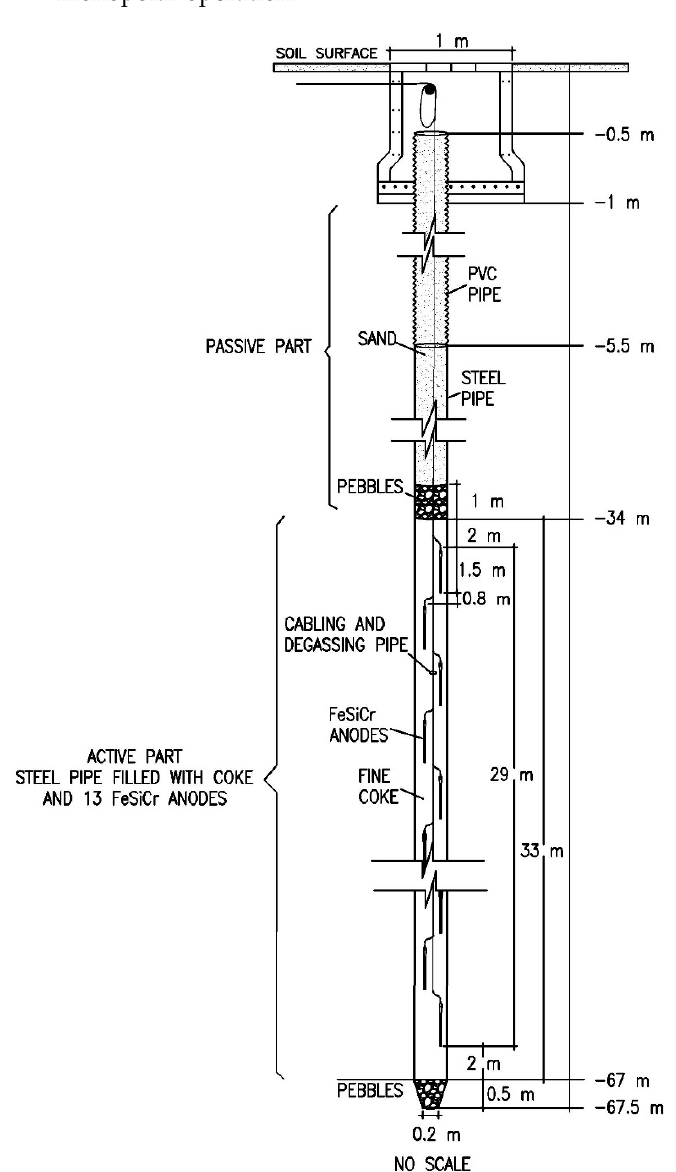
Figure 2. Well construction, 67 m depth.